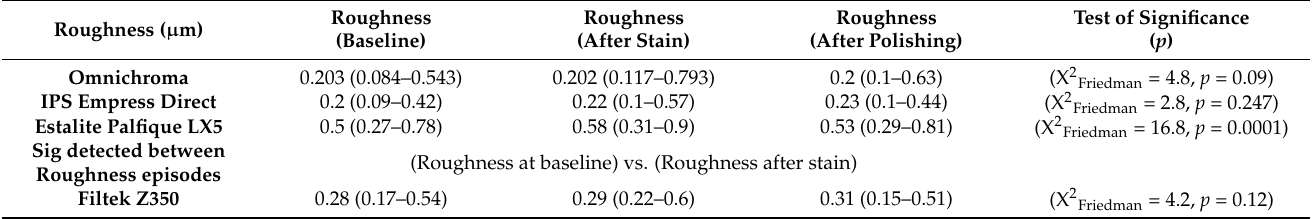
Table 4. Comparison between roughness in each group separately for resin composites at baseline (T0), after staining (T1), and after polishing (T2).